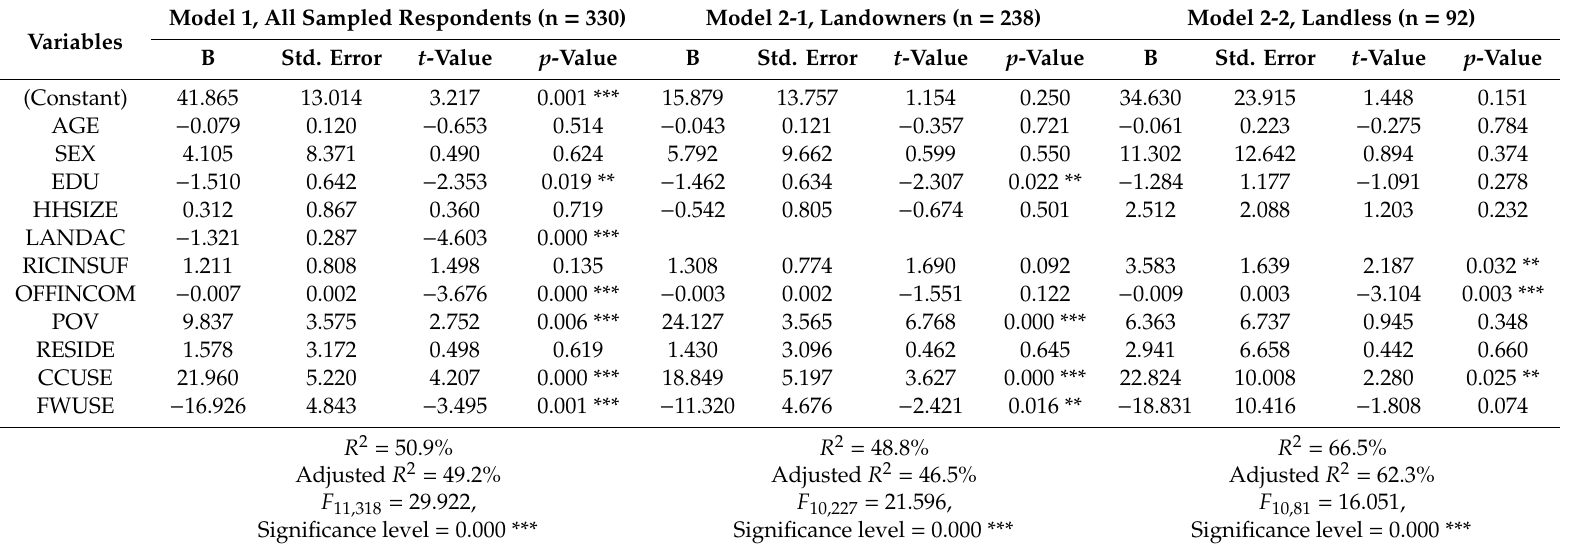
Table 5. Estimation of the e ff ect of socio-economic characteristics and fuelwood usage on NTFP dependence by household group: Full sample, landowners, and